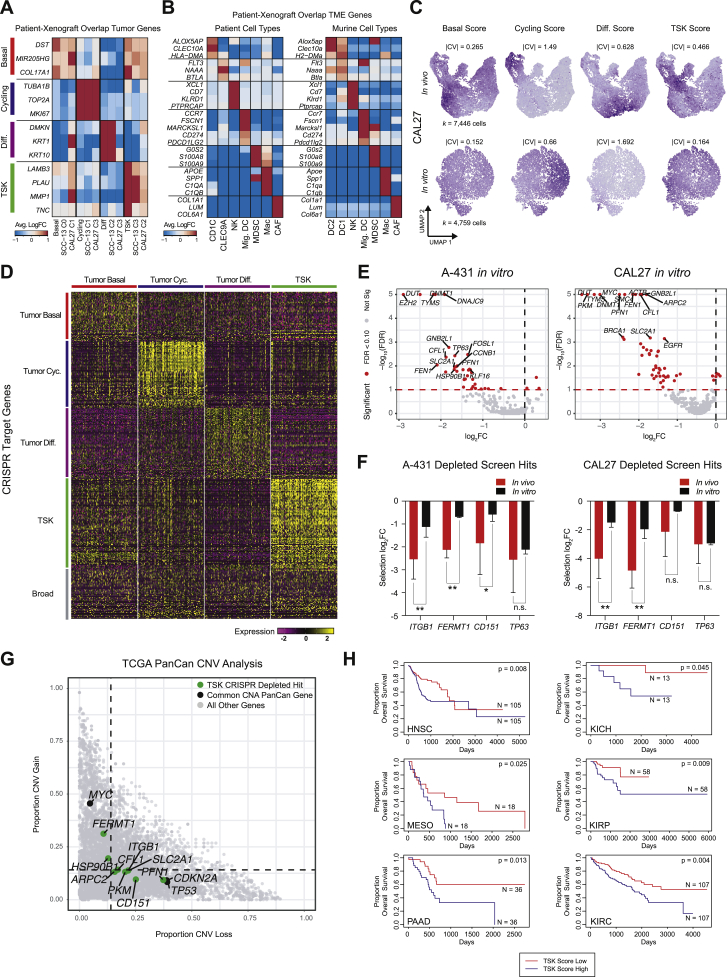
Analysis of In Vivo and In Vitro CRISPR Screen, Related to Figure 7(A) Heatmap displaying average log fold-change of each tumor subpopulation-identifying gene relative to other subpopulations in corresponding patient sample or SCC cell line. (B) Heatmap displaying average log fold-change of each TME cell type-identifying gene relative to other cell types in either patient tumors or murine xenografts. (C) UMAP feature plots displaying patient-derived tumor subpopulation signatures for SCC cells harvested from xenograft tumors or in vitro culture. (D) Heatmap representing expression of genes targeted in CRISPR screen. Genes are grouped as tumor subpopulation-specific or broadly expressed (STAR Methods). (E) Volcano plots representing STARS false discovery rates (FDRs) and log2 fold-change (log2FC) values for each in vitro xenograft screen. Red dotted lines represent FDR 0.10. (F) Log2 fold-change (log2FC) values of select genes from CRISPR screens in vivo versus in vitro. Error bars represent standard deviation across tumor or cell culture biological replicates. Significance determined by permutation (STAR Methods). (∗∗: Permutation FDR < 0.05, ∗: Permutation FDR < 0.1). (G) Comparison of mean CNV gain and loss proportions across 31 TCGA tumor types for all genes. TSK-expressed CRISPR hits and control recurrently altered genes are highlighted. (H) Kaplan-Meier plots for TCGA tumor types with patients stratified by expression of TSK signature. P value derived from chi-square test.